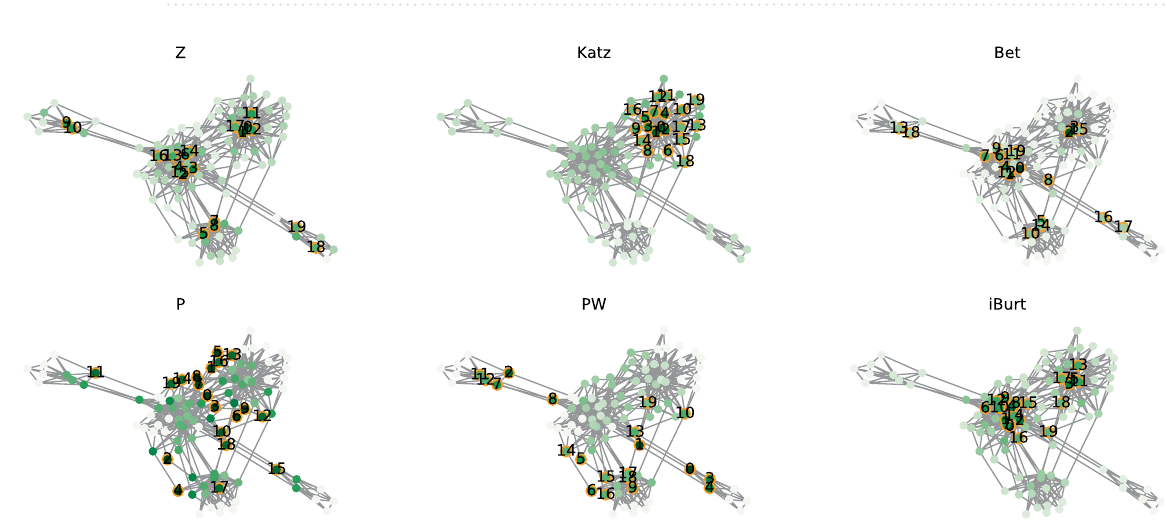
Figure 4. Index values of nodes in the LFR network. Each network has 100 nodes colored by their index values, 391 edges, and five communities with a mixing rate of 0.1. Top 20 nodes are marked by orange circles with labels of the node ranking in each network. The values of the top 20 nodes can be found in Supplementary Table